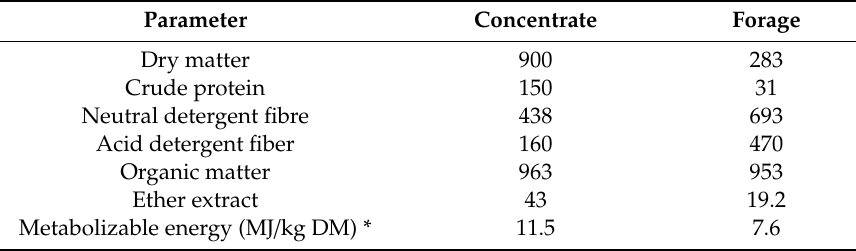
Table 1. Chemical composition (g / kg of dry matter) of the concentrate and forage o ff ered to lactating ewes. Parameter Concentrate